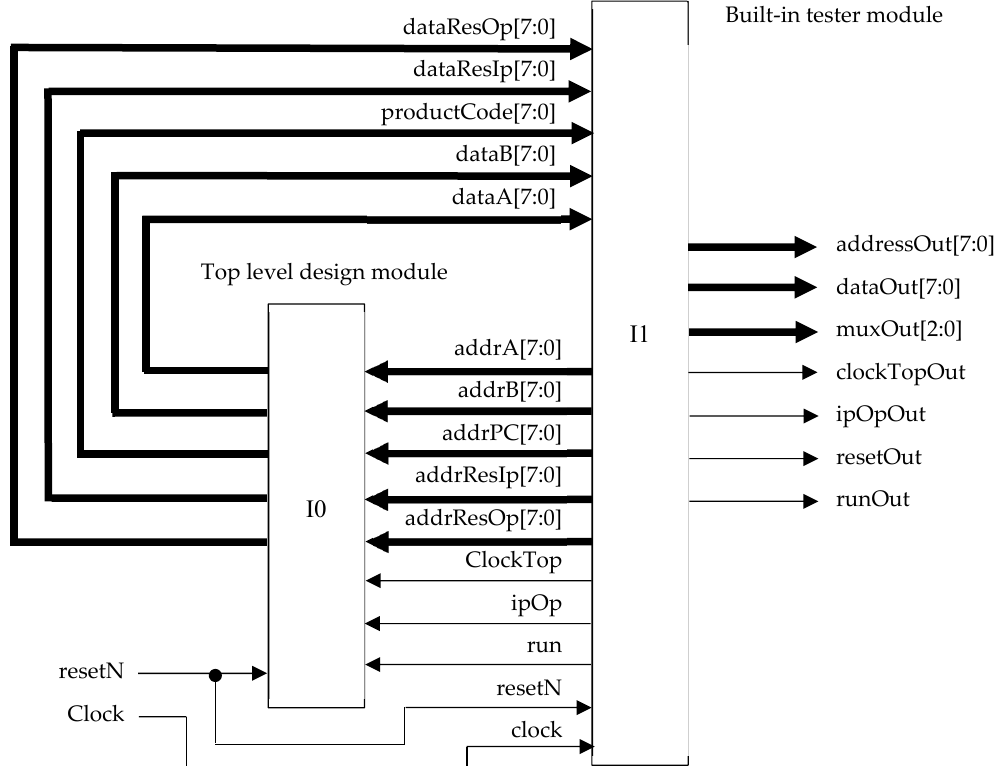
Figure 13. Embedded hardware tester: Simplified schematic view of the elaborated VHDL code.